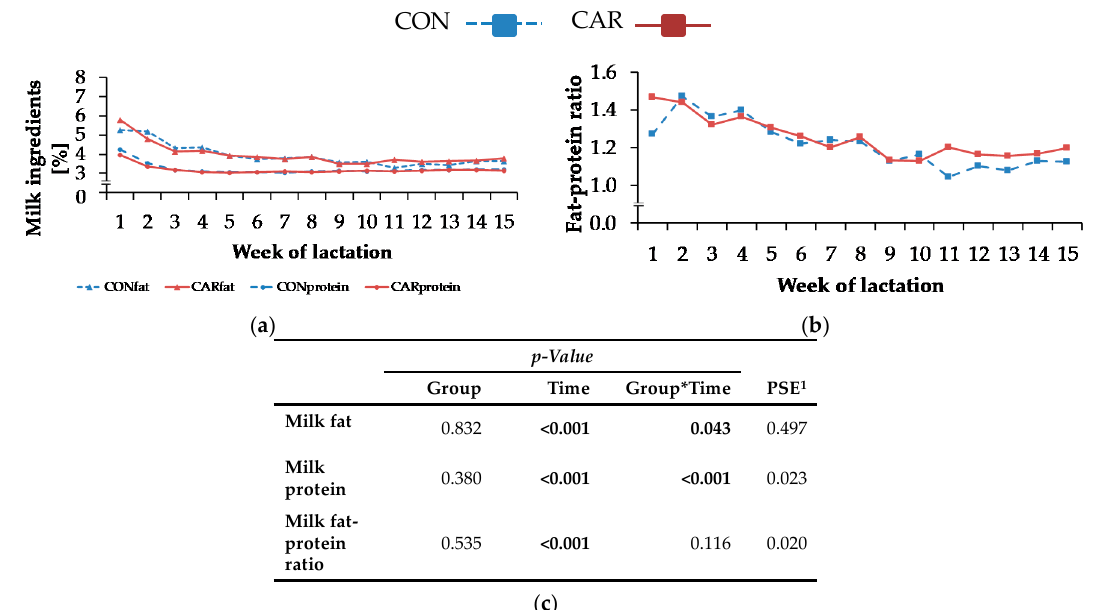
Figure 2. ( a ) Milk fat and protein and ( b ) fat-protein ratio in milk of cows fed a non-supplemented (CON) or an L-carnitine-supplemented diet (25 g/d from 6 weeks ap up to week 15 pp , CAR). ( c ) Data statistics. Data are given as LS-means. 1 pooled standard error.